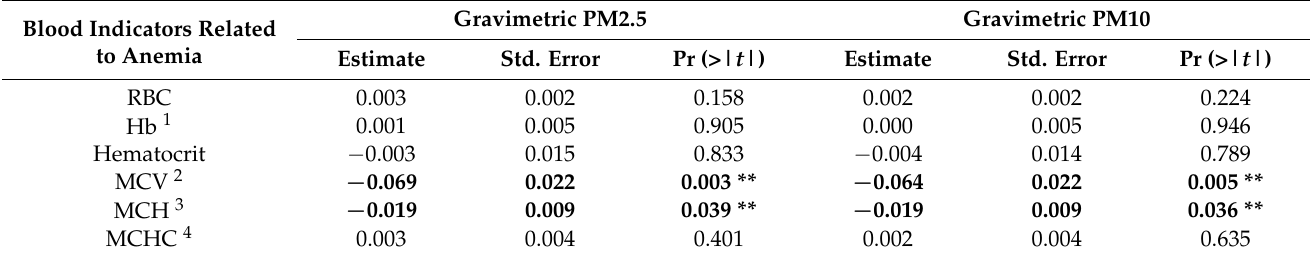
Table 2. Regression model of baseline particulate matter (gravimetric method) for blood indicators related to anemia. Gravimetric Blood Indicators Related to Anemia